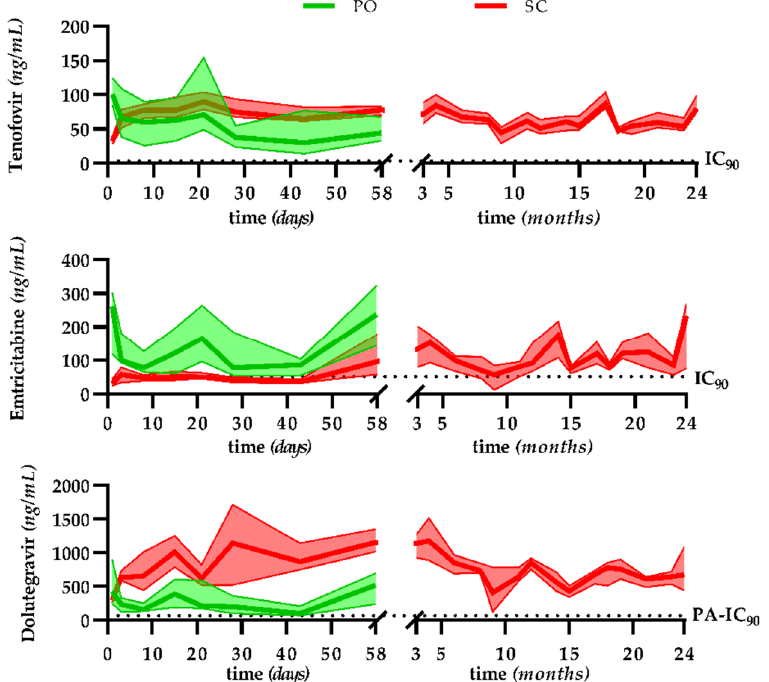
Figure 2. Tenofovir, emtricitabine, and dolutegravir trough plasma concentrations during long-term treatment of SIV + macaques. The continuous lines and coloured areas represent the median and interquartile range, respectively. Oral (PO) route: green, subcutaneous (SC) route: red. Abbrevia- tions: IC 90 : wild-type HIV-1 90% inhibitory concentration, PA-IC 90 : protein-adjusted wild-type HIV- 1 90% inhibitory concentration.